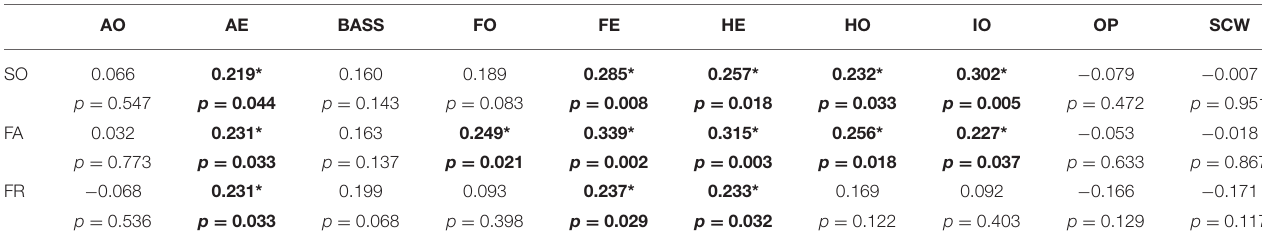
TABLE 3 | Results of the correlation analysis (Spearman’s rho) for women with DRAM in the 13–24 months postpartum period ( N = 85).